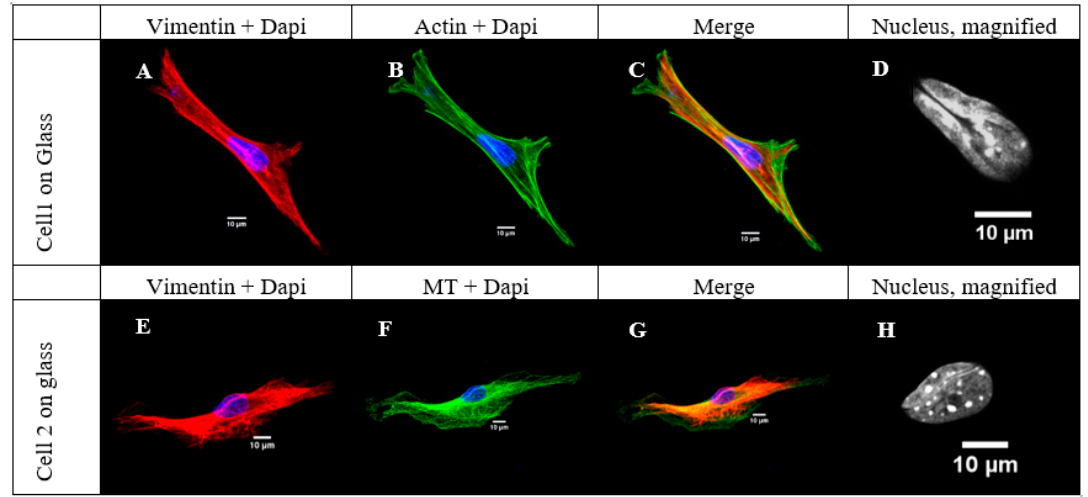
Figure 2. Examples of two cells cultured on glass, stained for vimentin, microfilaments, and nucleus (Cell1, panels ( A – D )) and for vimentin, microtubules (MT), and nucleus (Cell2, panels ( E – H )). Nucleus presented in magnification—with a clear groove, characteristic of “coffee-beans” nuclei.